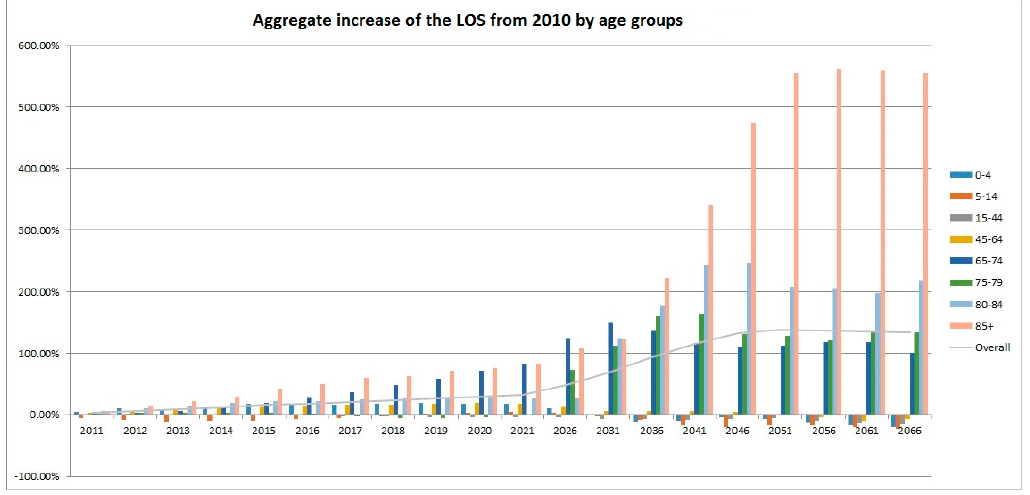
Figure 5. Percentages of the LOS by age group column chart. Figure 6 presents the projected number of days of hospitalisation and hospital-free years at birth across birth cohorts. Two sets of results are projected for the years 2010 to 2066. Note that unless death has been observed before 2011, since the majority of the lifetime of the individuals born in the year is unknown, a projection is also necessary for the year 2000. The first set of results is illustrated by stacked columns with units of days. The columns show the expected total number of days a person spends in hospitals from birth to age 95 years for different birth years. It can be seen that starting from 2010, both genders have a general increasing trend. The number for females would increase from 108.5 days in 2010 to 139.3 days in 2066, while for males the number would increase from 106 days in 2010 to 143.8 days in 2066, displaying a faster speed of increase. Also, starting from 2031, it is projected that males would spend longer time in hospital during their lifetime than females, which could be interpreted as males in general falling ill more often than females, as the latter have longer life expectancies. Since the sole hospitalisation experience in 2010 is adopted for the whole projection period, the slow increasing trend for both females and males could be assigned to the expected improvement in mortality experience in the future.